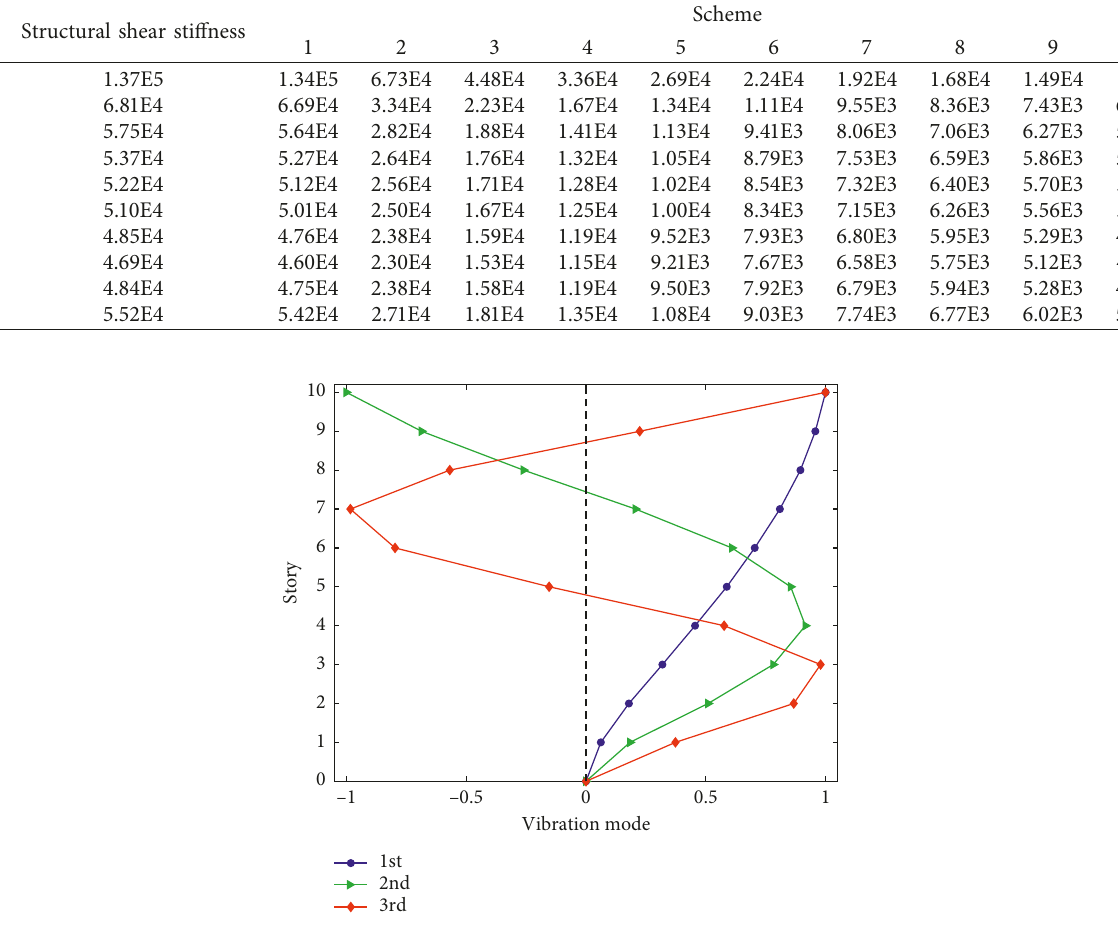
for each story of all schemes (unit: kN/m). re